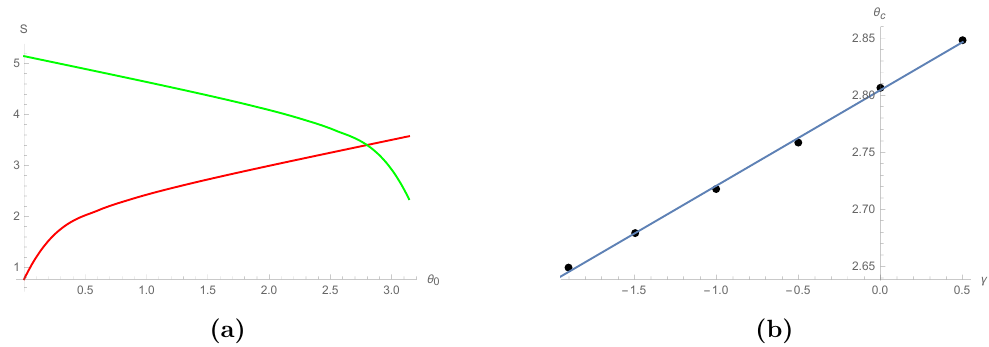
Figure 2. d = 3. a) shows the Wald entropy for the connected (blue) and disconnected (orange) surfaces as a function of the boundary region (cid:18) 0 . We have used (cid:22) 0 = g = (cid:12) = G = 1 and (cid:13) = (cid:0) 0 : 1. b) Critical angle (cid:18) c versus (cid:13) , also with g = (cid:22) 0 = (cid:12) = G = 1. to plot j S (cid:0) S j =S as a function of (cid:18) , we would see an entanglement 0 A thermal A C